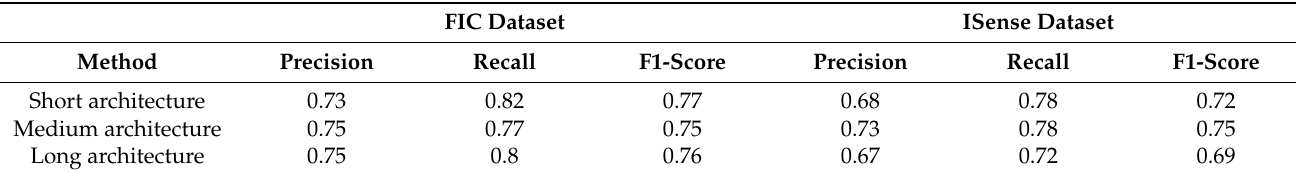
Table 1. Results of the DL models on the FIC and ISense datasets—food intake detection. FIC Dataset